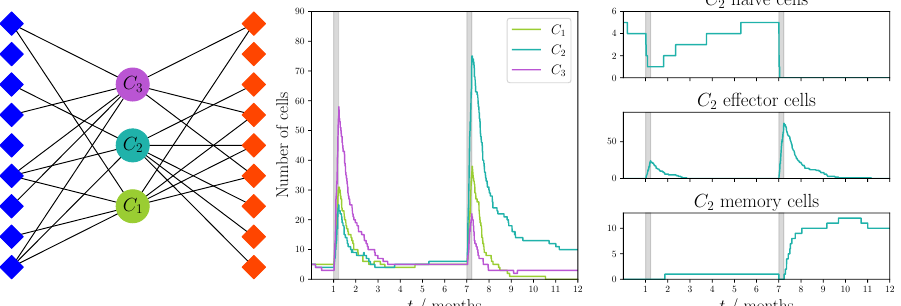
Figure 11. Single realization of an immune response to two viral challenges with a focused fixed degree recognition network and dynamics defined in Section 5.1. The network was constructed using the sampling strategy described in Section 4.1.2 with degree k = 8. Blue diamonds represent VDPs present during the first viral challenge and red diamonds represent those present during the second challenge. We note that not every VDP is recognized by the clonotypes. Model parameters are described in Table 2. The python code used to generate this figure has been made available at https://doi.org/10.5281/zenodo.5227343 [84].